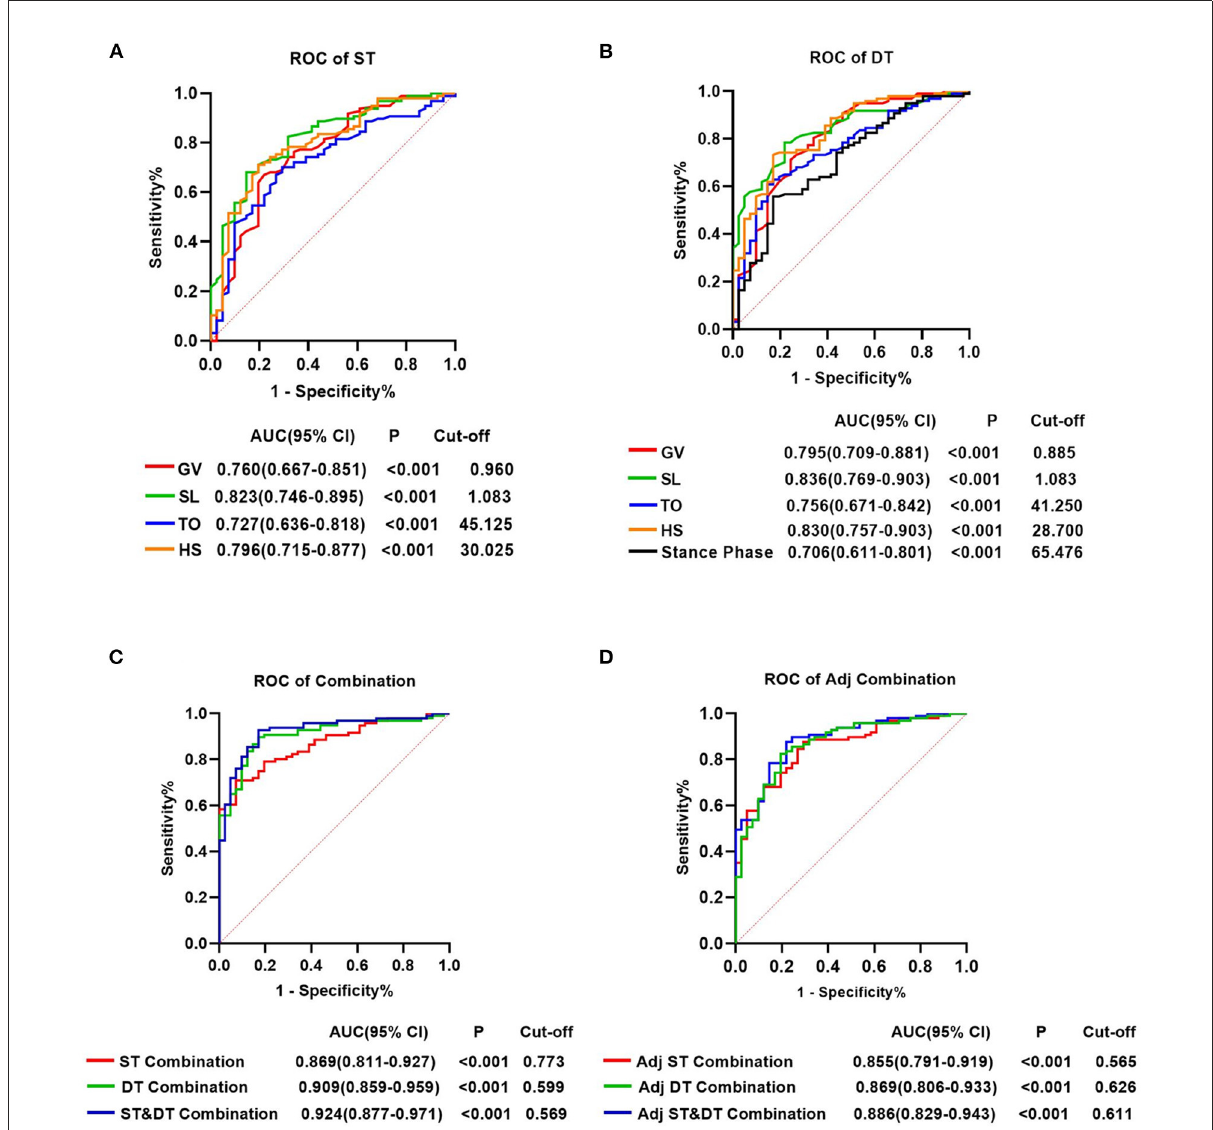
FIGURE3 Receiver operating characteristics analysis plots for gait parameters distinguishing the individuals with early-stage Parkinson’s Disease and healthy controls. (A) GV, SL, TO, and HS for identifying patients with PD in the single task walking test. (B) GV, SL, TO, HS and stance phase for identifying patients with PD in the single task walking test. (C) ST-Combination, receiver operating characteristics (ROC) analysis for the combination of GV, SL, TO, HS, swing time, stance phase, CV-HS, CV-SL, and AI-SL under ST; DT-Combination, DT-Combination, ROC analysis for the combination of GV, SL, TO, HS, stance phase, CV-SL, AI-SL, CV-TO, CV-HS, CV-Swing time and AI-Swing time under DT; ST&DT-Combination, ROC analysis for the combination of all gait parameters with diagnostic values under ST and DT. (D) Adj ST-Combination, ROC analysis for the combination of GV, SL, swing time, stance phase, and HS under ST. Adj DT-Combination, ROC analysis for the combination of GV, SL, stance phase, and HS under DT. Adj ST& DT-Combination, ROC analysis for the combination of ST-GV, ST-SL, ST-swing time, ST-stance phase, ST-HS, DT-GV, DT-SL, DT-stance phase, and DT-HS. AUC, area under the curve; CI, confifidence interval; cut-off, cut-off point; ST, single task; DT, dual task; GV, gait velocity; SL, stride length; TO, toe-off angle; HS, heel strike angle; CV, coefficient of variation; AI, asymmetry